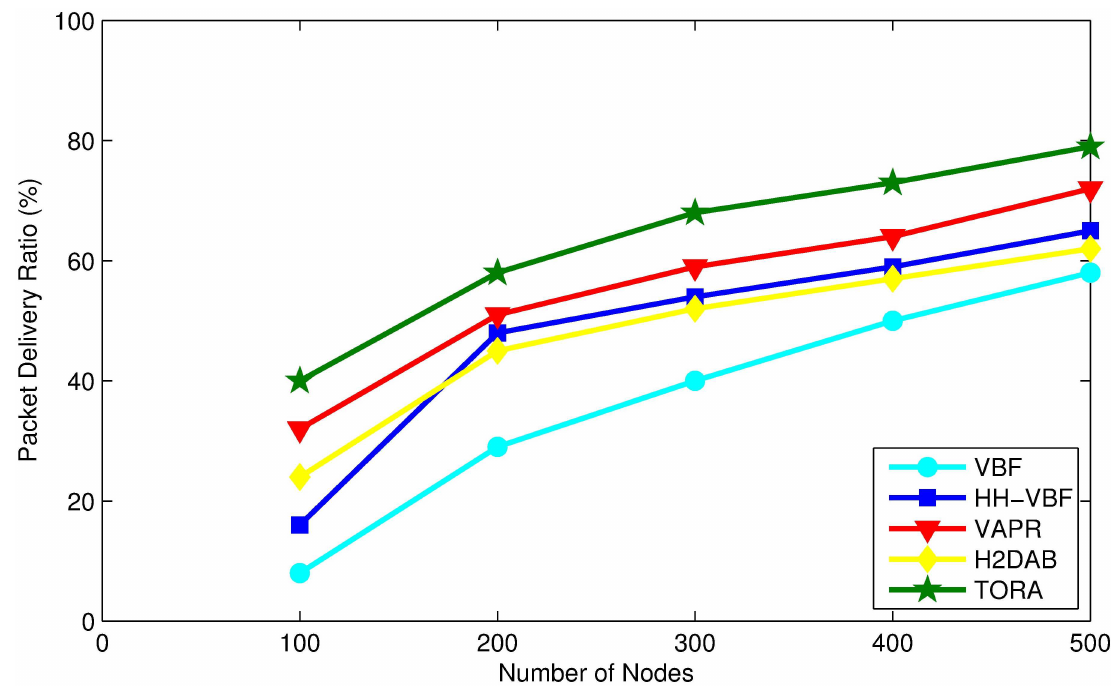
Fig 9. Packet delivery ratio vs. node